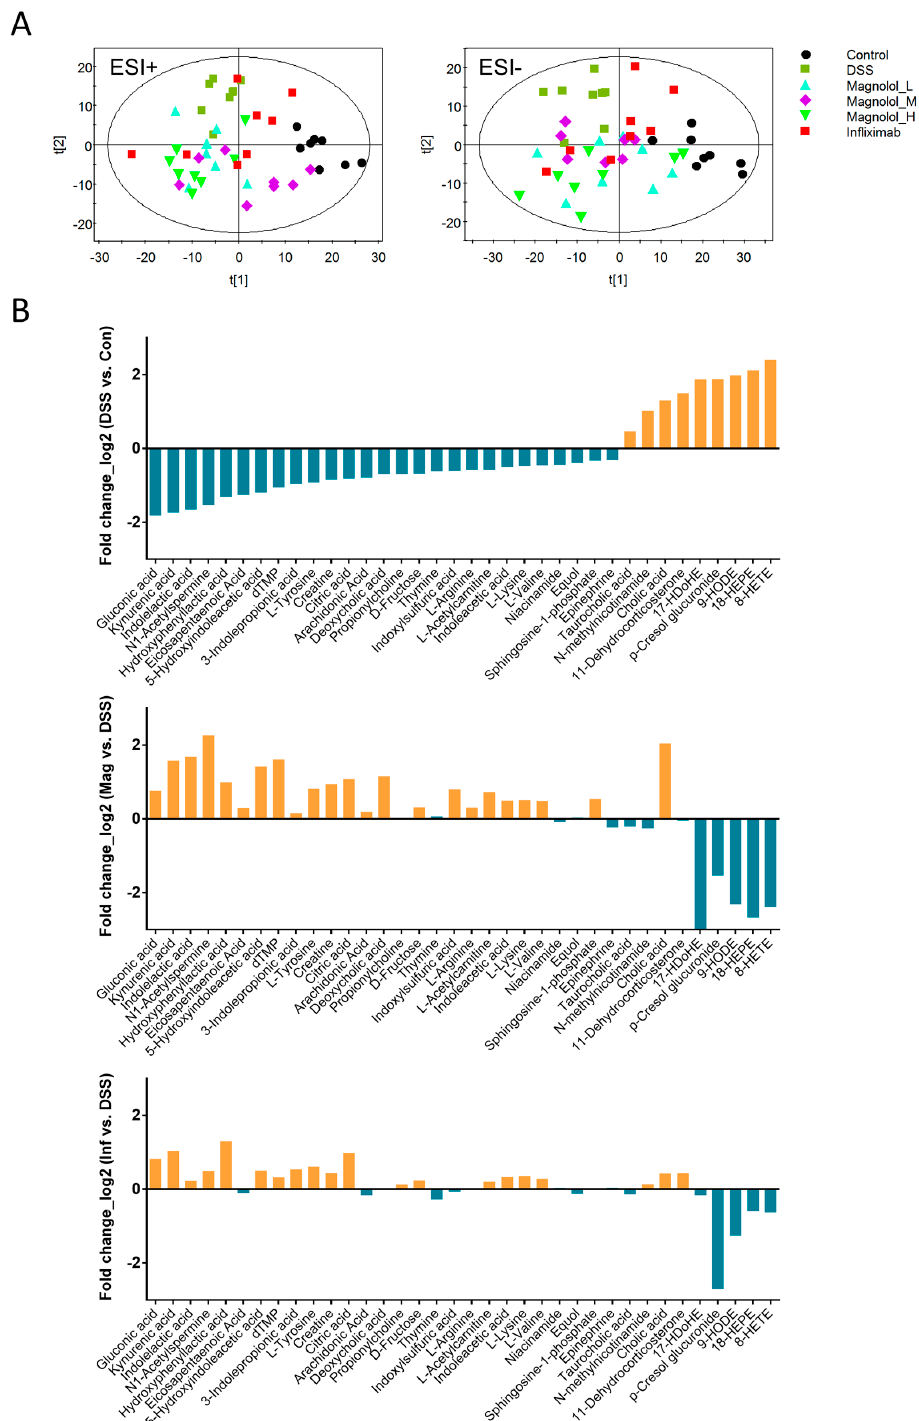
Figure 4. Magnolol majorly reversed abnormality of serum metabolome in colitis mice. ( A ) Two dimensional partial least squares discriminant analysis (PLS-DA) scatter plots displayed distinct metabolic profiles among model mice with and without drug treatment through UPLC/MS-based serum metabolomic analysis in both ESI modes. The variables explained 23% (t1) and 13.6% (t2) in ESI positive mode, while the variables explained 20.9% (t1) and 10.9% (t2) in ESI negative mode. ( B ) The log2 fold changes of all identified metabolic features between groups of DSS and control, groups of medium dose of magnolol and DSS as well as groups of infliximab and DSS.